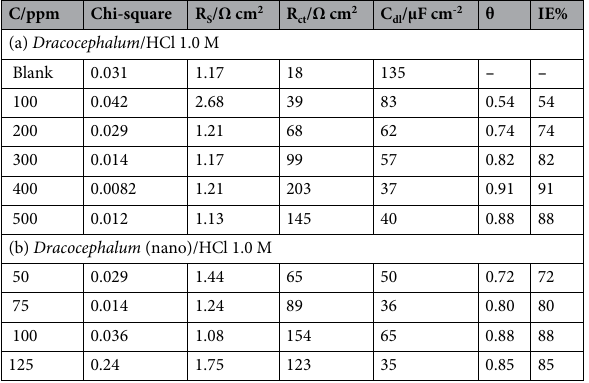
Table 3. Corrosion parameters derived from Nyquist curves for st-37 in HCl solution in the absence, and presence of different concentrations of inhibitor based on bulk, and nano size, at 25 ± 1 °C.